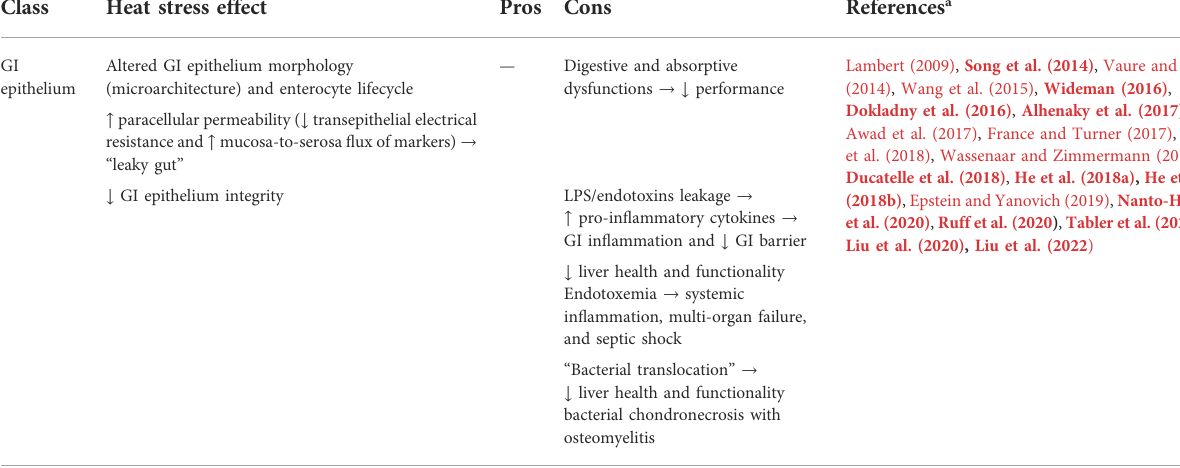
TABLE 6 Overview of heat stress effects on the GI epithelium of